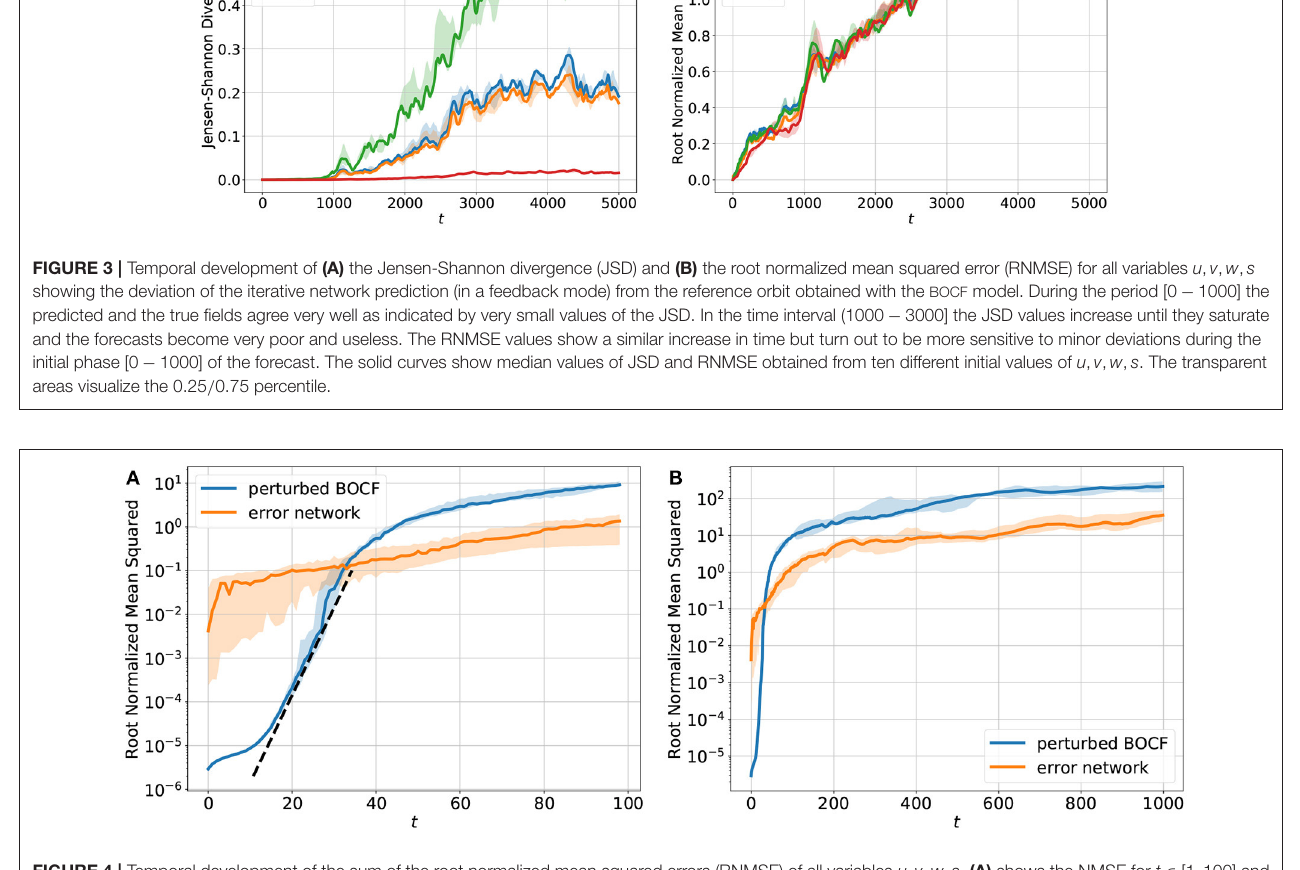
FIGURE 4 | Temporal development of the sum of the root normalized mean squared errors (RNMSE) of all variables u , v , w , s . (A) shows the NMSE for t ∈ [1,100] and (B) shows the NMSE for t ∈ [1,1000]. The orange curve describes the deviation of the trajectory generated by the network from the reference orbit simulated with the BOCF model. For comparison the blue curve shows the distance between the reference orbit and a second solution of the BOCF model obtained by perturbing the initial conditions where each variable was perturbed at every spatial location using Gaussian random noise ( µ = 0, σ 2 = 10 − 11 ). The error dynamics of ten perturbed trajectories was analyzed. These orbits were obtained by perturbing the reference orbit at different times [0,1000), [1000,2000), ... [9000,10000). The blue curve shows the median and the 0.25 / 0.75 percentile is visualized by the transparent areas. The dotted black line (A) denotes the slope the linear part of the log(NMSE) vs. t curve which provides an estimate of the largest Lyapunov exponent [ 40] λ 1 ≈ 0.25 (with respect to the natural